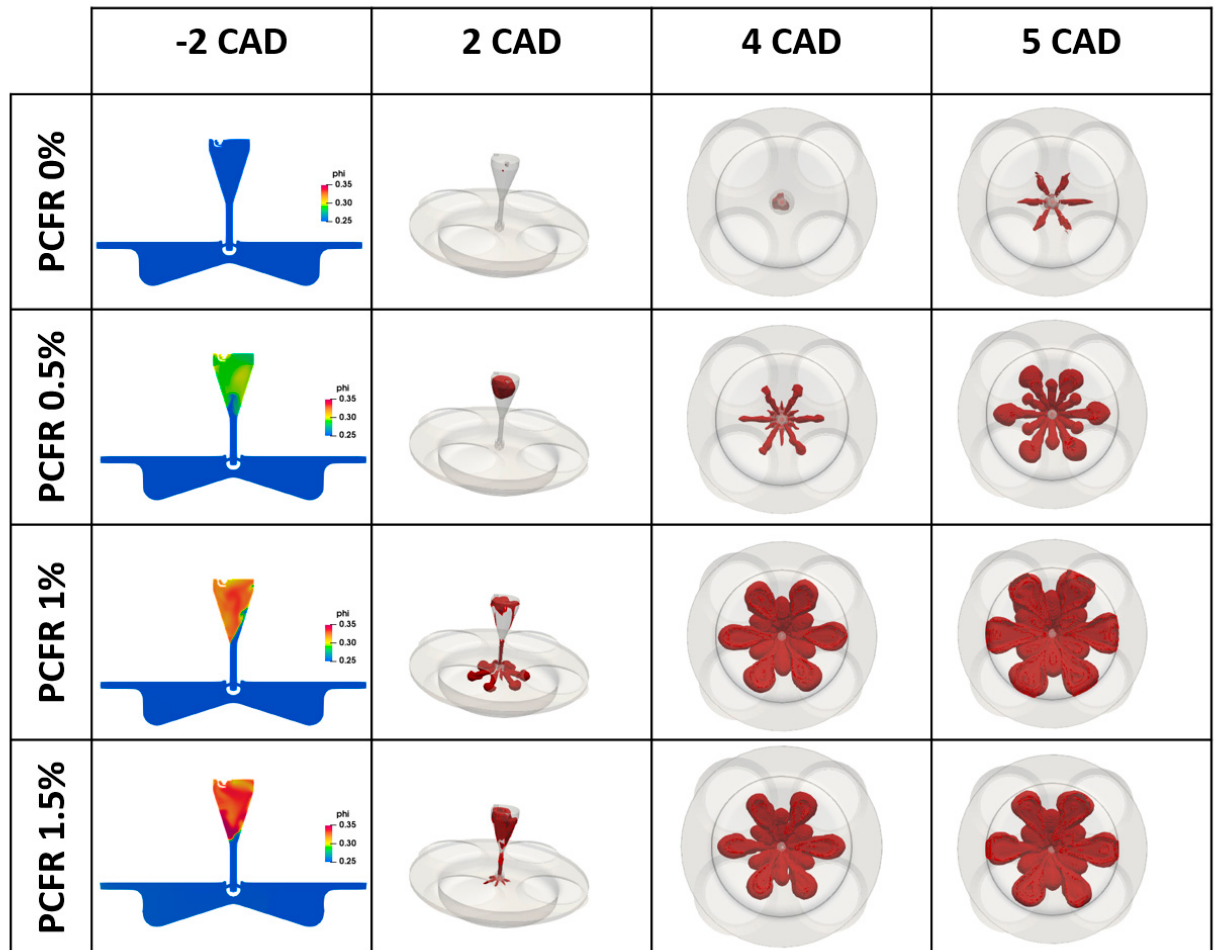
Figure 18. Comparison of ϕ and iso-surface (1600 K) of temperature using CR = 14, λ = 4, and ST = − 2° using different PCFRs.